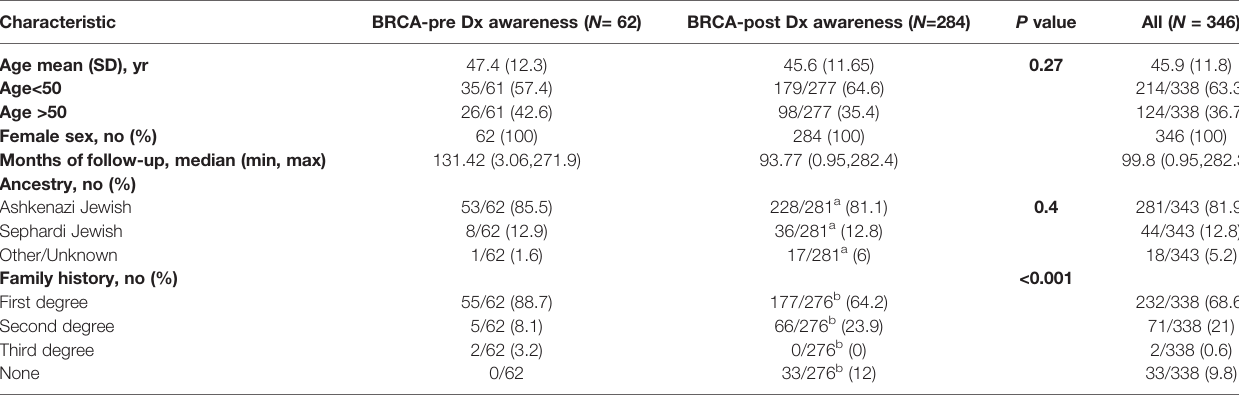
a Missing data of ancestry was missing for three patients. b Missing data of family history was missing for eight patients. (Right) All patients. (Left) Comparison of the BRCA-preDx awareness group with the BRCA-postDx awareness group.